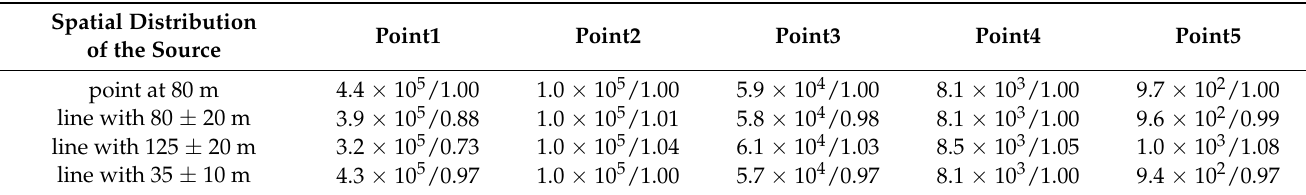
Table 4. Deposit of Cs-137, seven days from the beginning of the release of 1 × 10 15 Bq, in various points, as a function of initial spatial distribution of the source. Dry deposit, [Bq/m 2 ], and ratio to dry deposit in case of point source at 80 m. Spatial Distribution